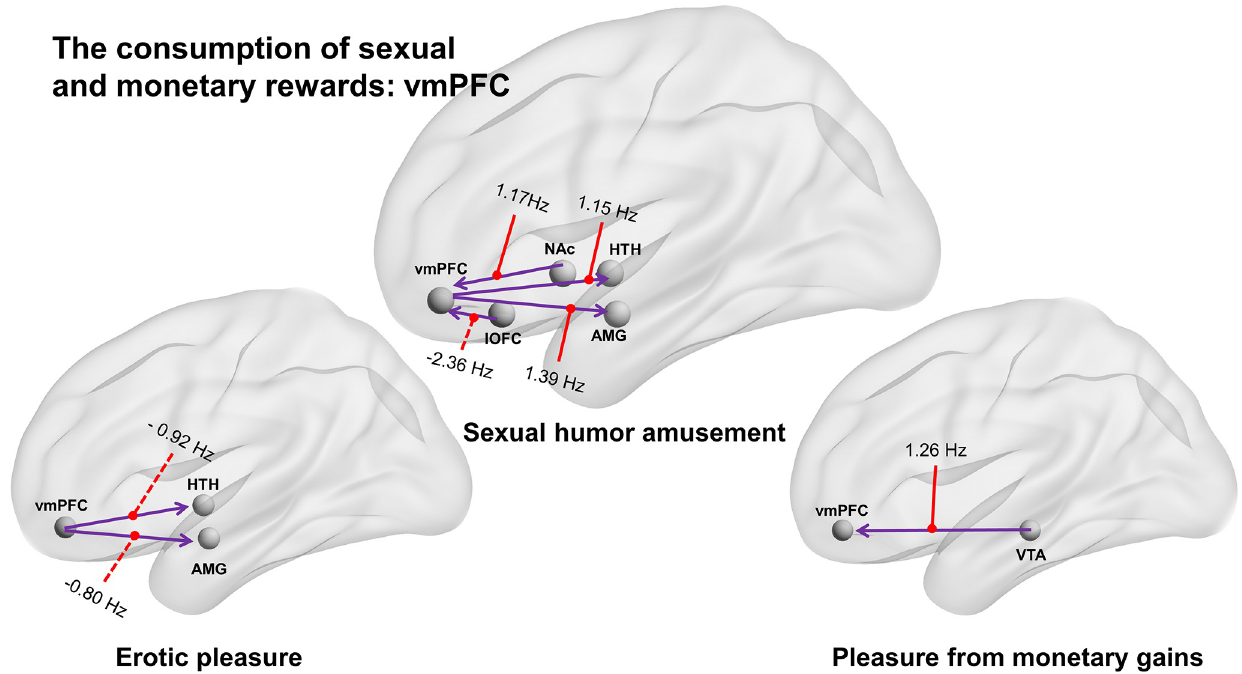
Fig 4. Effective connectivity in processing the consumption of erotic, sexual humor and monetary rewards with hedonic ratings as covariates during the outcome phase in the vmPFC. (Left) Erotic pleasure was associated with negative modulatory effects from the vmPFC to both the amygdala and hypothalamus (vmPFC ⇢ amygdala; vmPFC ⇢ hypothalamus). (Middle) Conversely, sexual humor appreciation was associated with positive modulatory effects in the effectivity connectivity from the vmPFC to the amygdala (connection strength = 1.39 Hz). Also, sexual humor appreciation was associated with positive modulatory changes in effectivity connectivity from the vmPFC to the hypothalamus (vmPFC ! hypothalamus) and from the NAc to the vmPFC (NAc ! vmPFC). (Right) Pleasure from monetary gains was associated with positive modulatory changes of effectivity connectivity from the VTA to the vmPFC (VTA ! vmPFC; connection strength = 1.26